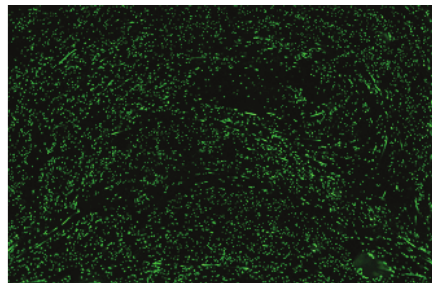
Figure 5: Cross-sectional fluorescence image of ECC-SL mixture